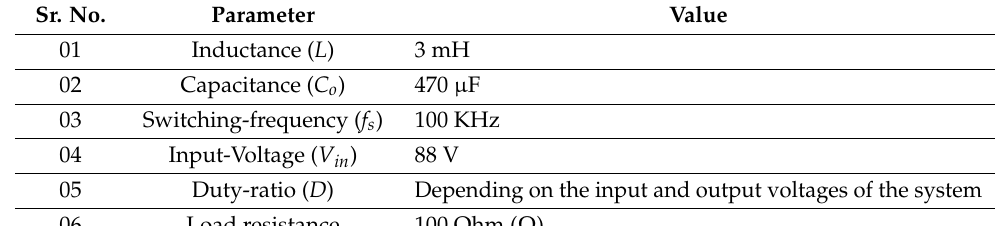
Table 2. Specification of Boost Converter.